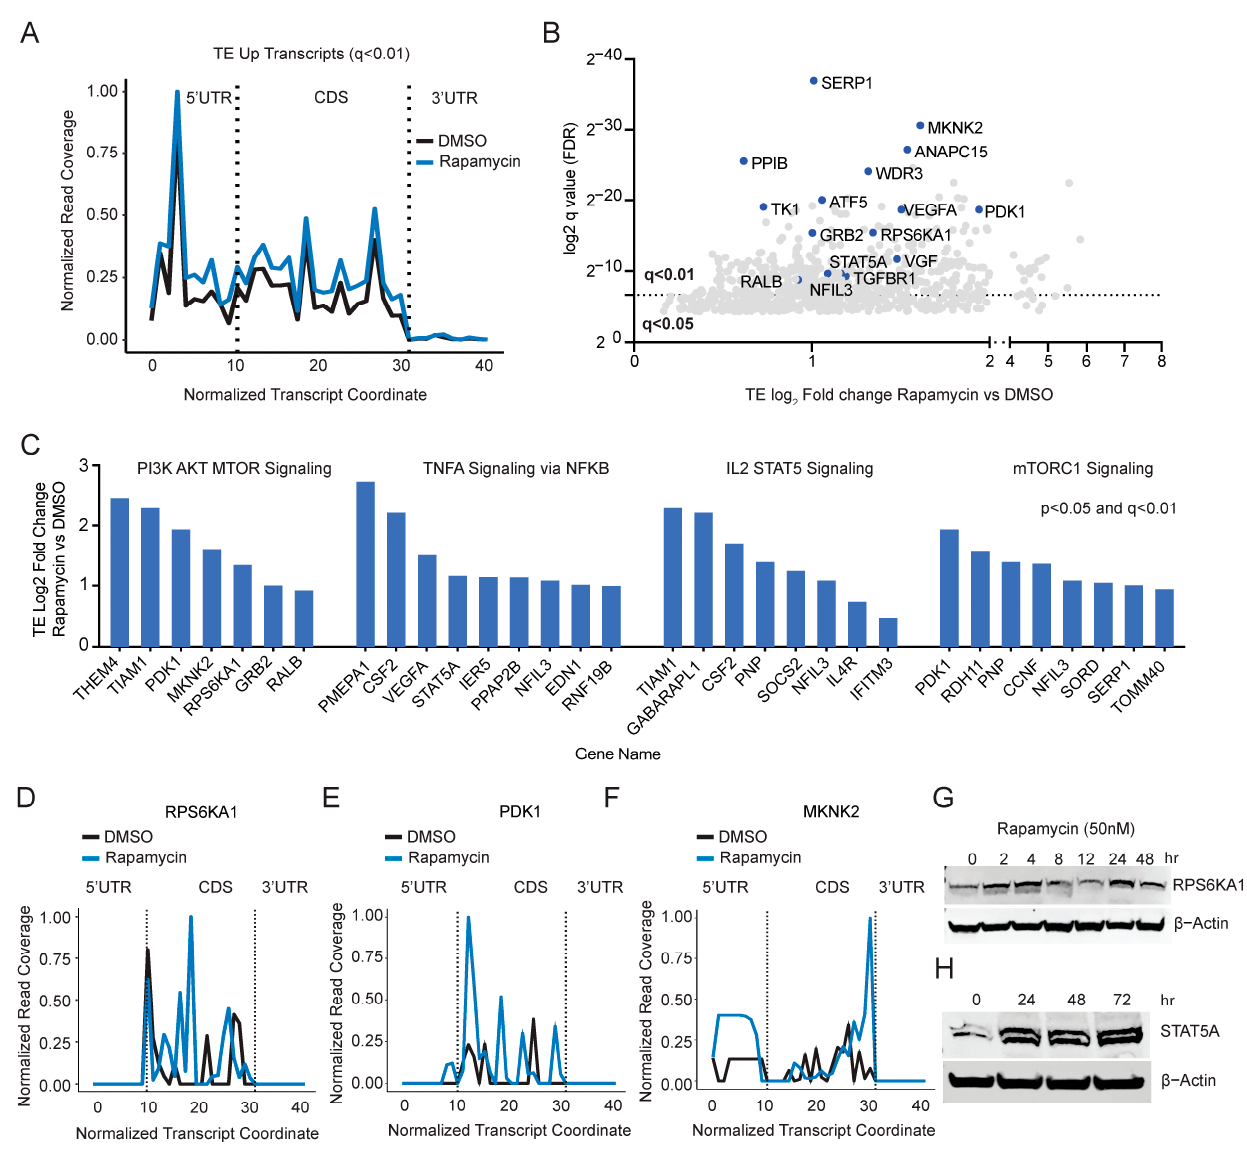
Figure 3. Rapamycin induces the translation of a subset of mRNAs. ( A ) Metagene plot showing that the ribosome read coverage is increased throughout the mRNA length in the TE up mRNAs (q < 0.01) in rapamycin-treated PANC-1 cells compared to the DMSO. RF coverage and transcript length are normalized. ( B ) TE up genes ranked by q-value. Translationally upregulated genes involved in PI3K-AKT-mTOR and cancer signaling are highlighted in blue. ( C ) TE (log2-fold change) of key genes involved in PI3K-AKT-mTOR, TNFA, IL2-STAT5, and mTORC1 signaling. ( D – F ) Ribosome coverage is increased throughout the mRNA length in RPS6KA1, PDK1, and MKNK2 in rapamycin- treated PANC-1 cells compared to the DMSO. RF coverage and transcript length are normalized for comparison. ( G , H ) Immunoblots showing upregulation in the total protein of RPS6KA1 and STAT5A following rapamycin treatment (50 nM) for the indicated time points. b-actin is used as the loading